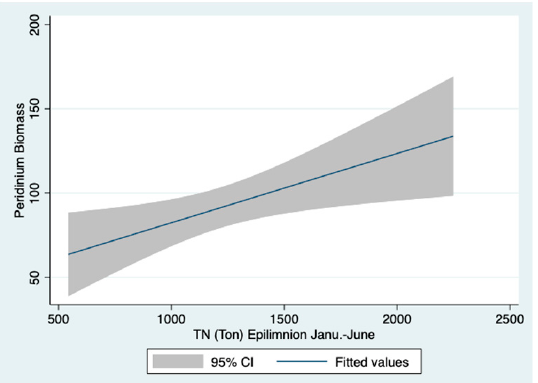
Figure 13. Linear prediction (95% CI) ( left ) and LOWESS smoother (0.8 bandwidth), trend of changes ( right ) between annual means of Peridinium wet biomass (g/m 2 ) and total nitrogen loads (ton) in the epilimnion of Lake Kinneret during 1970–2018.